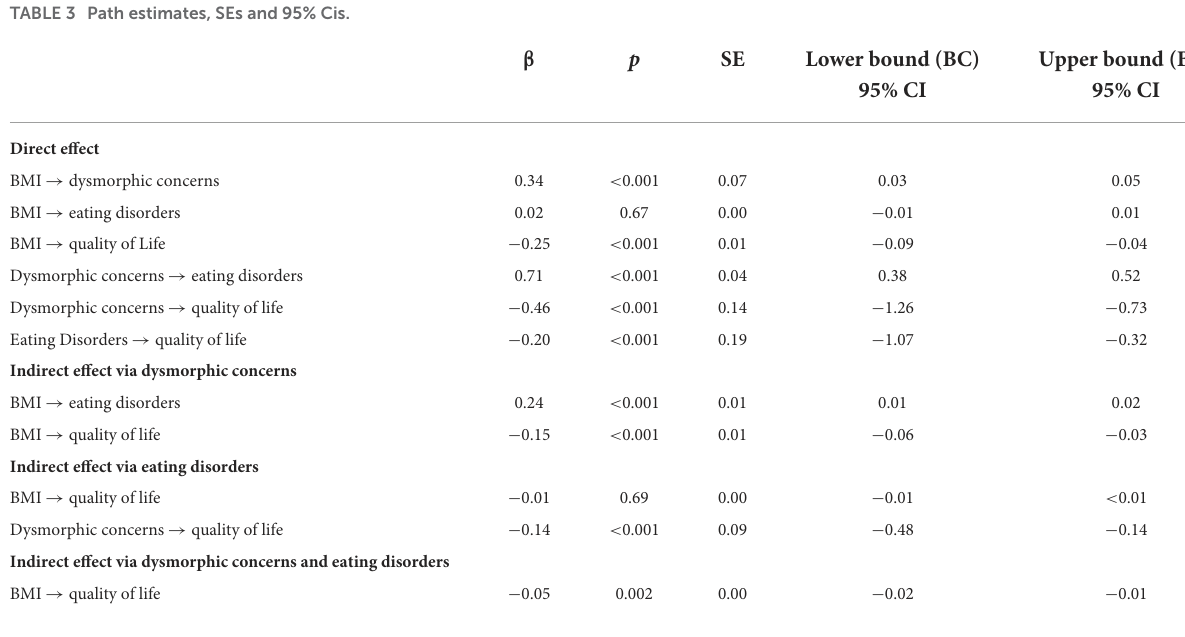
TABLE 3 Path estimates, SEs and 95%